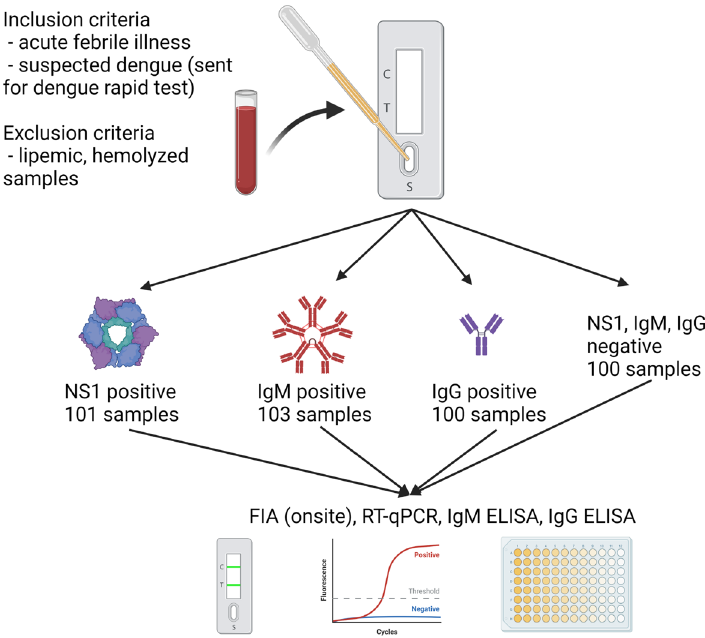
Figure 1. Flowchart of sample collection, categorization, and series of analytical tests, created by